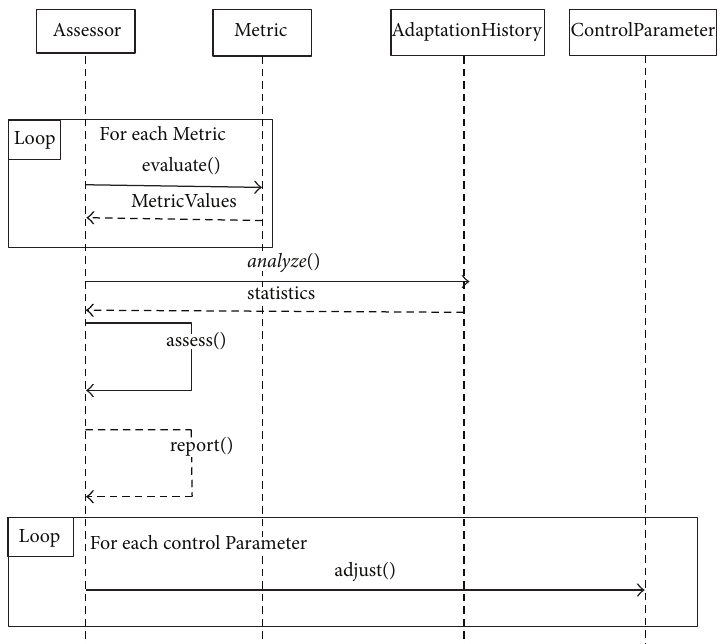
Figure 12: Behavioral view of the RTE Assessor pattern.